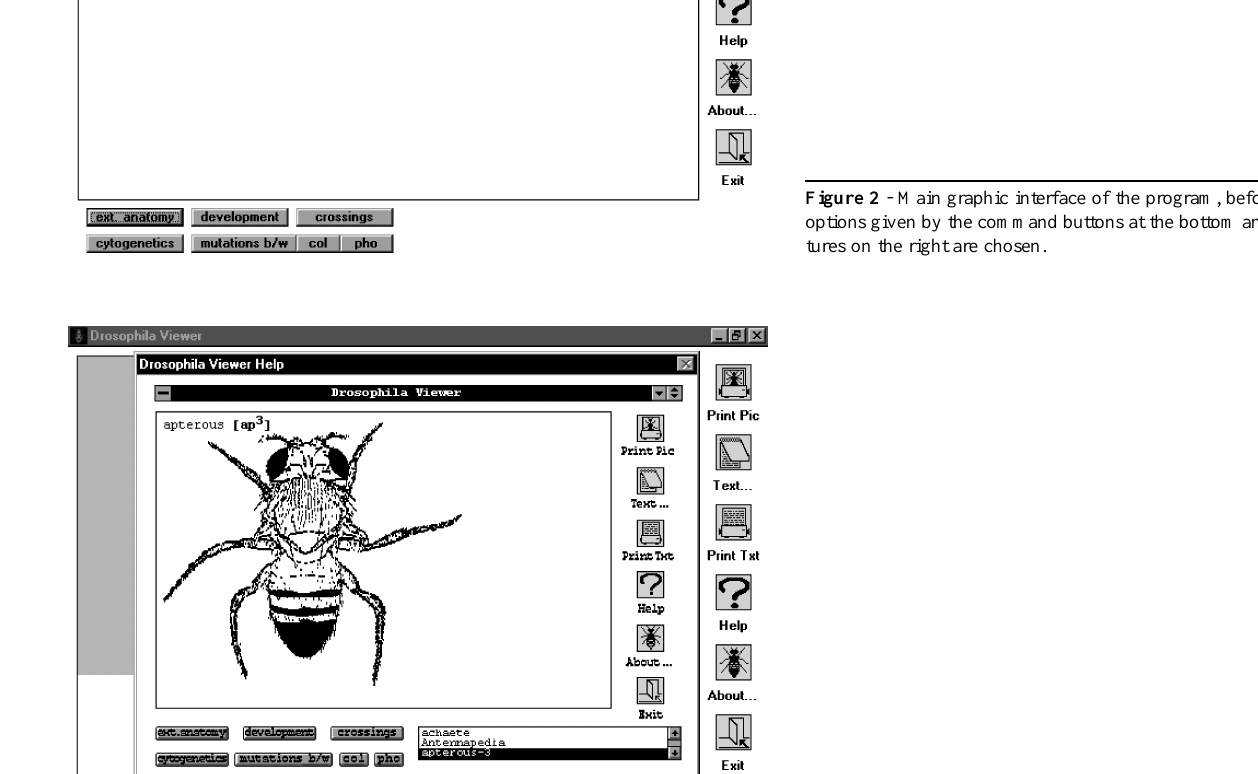
Figure 3 - Help interface of the program giving summarized instructions to run it and explanations about its functioning.